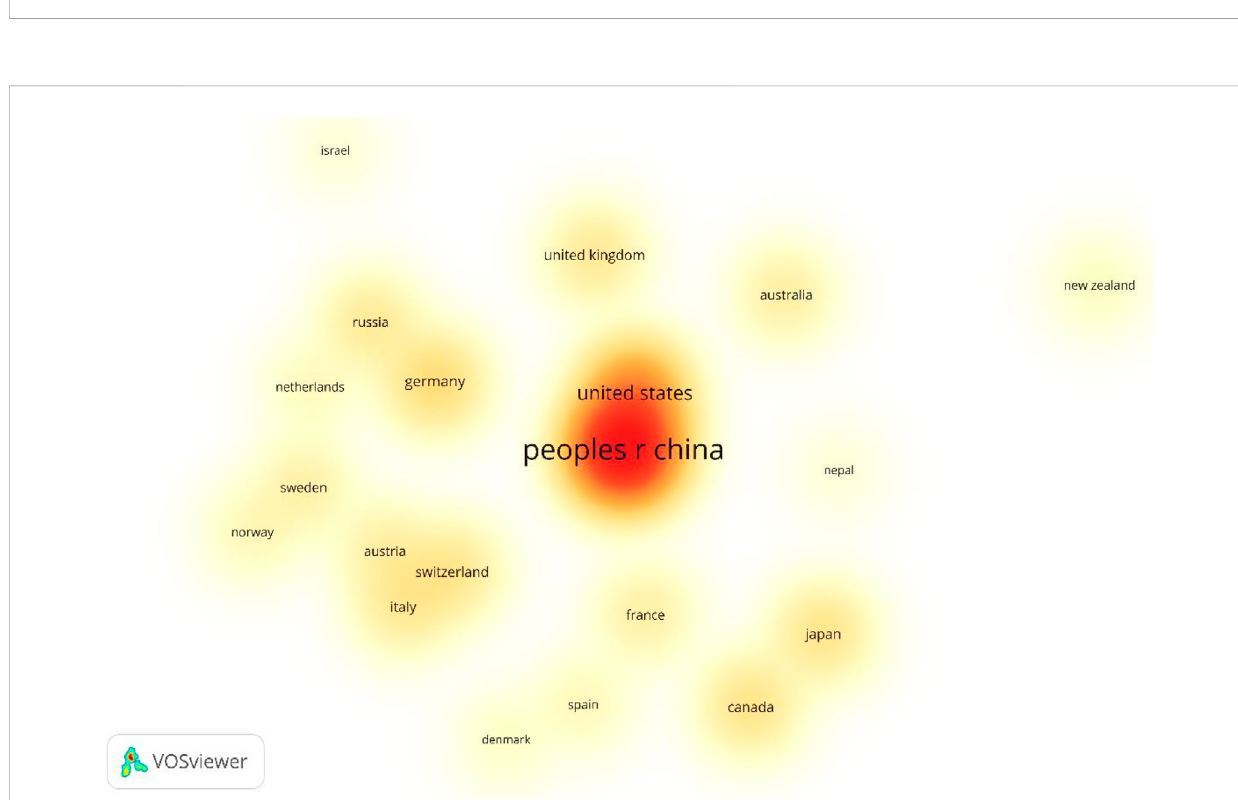
FIGURE 3 Analysis of the cooperation network among various countries/regions in the fi eld of alpine meadow research.